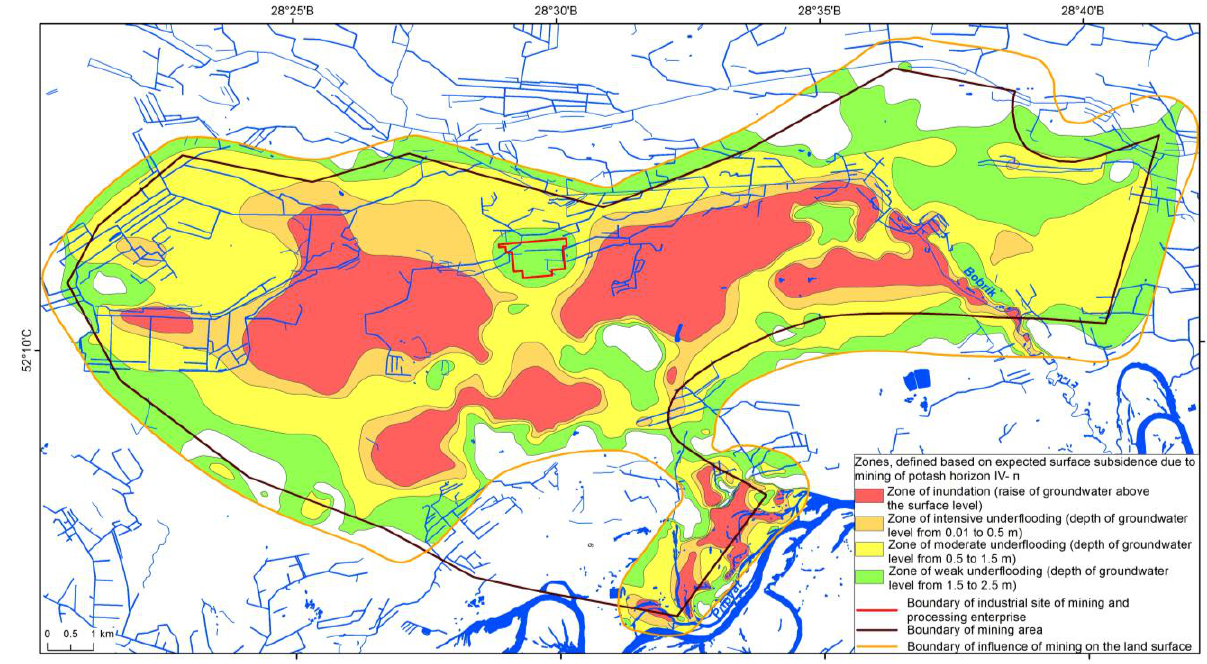
Fig. 5. Schematic map of the areas of possible inundation and under-flooding due to underground